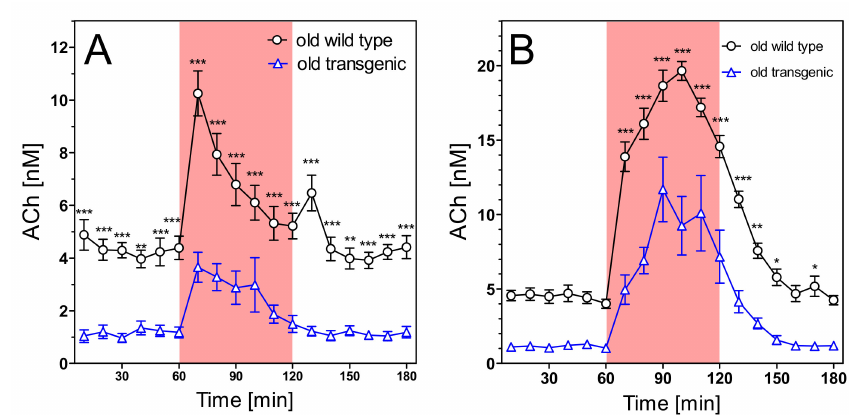
Figure 8. Extracellular ACh concentrations in hippocampus of 15–16 months old wild-type and transgenic rats during open field test ( A ) and under scopolamine perfusion ( B ). The red area represents the intervention (open field exposure or scopolamine perfusion) from 60–120 min, Data are means ± SEM ( n = 8–9) and were analysed by two-way ANOVA for genotype as variable followed by Bonferroni’s multiple comparison test: ( A ) F1,255 = 4.23, p < 0.001 ( B ) F1,255 = 5.29, p < 0.001. * p < 0.05, ** p < 0.01, *** p < 0.001.